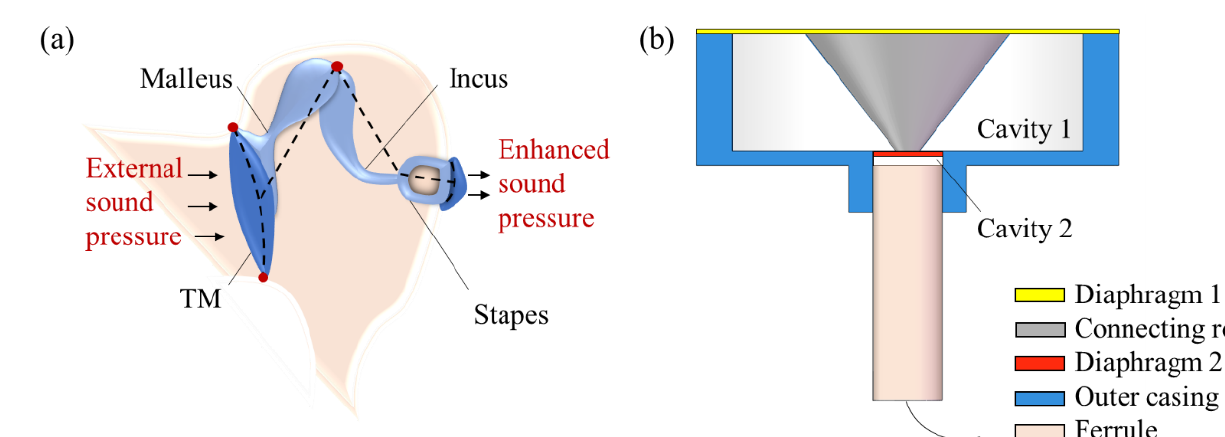
Figure 1. Schematic illustrations of ( a ) a human middle ear structure and ( b ) the presented SPAS with an F-P probe.